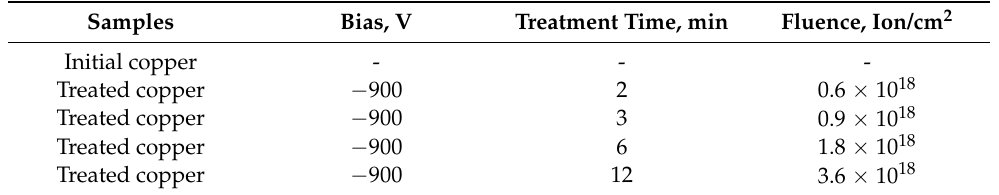
Table 1. Parameters of treatment of the copper alloy by titanium